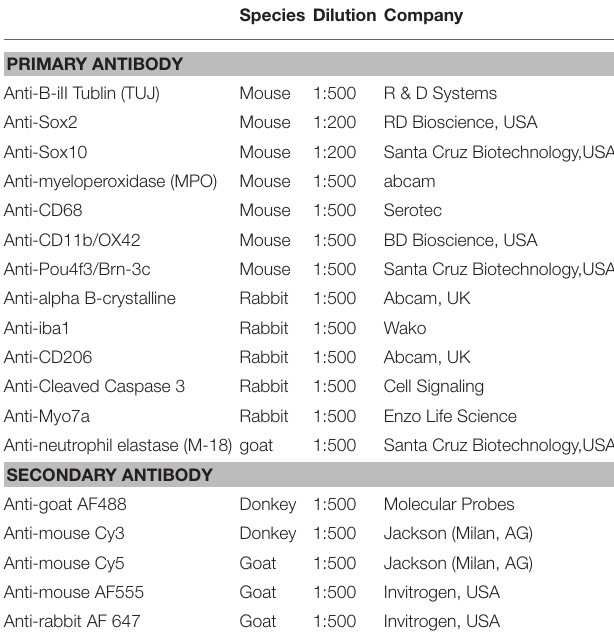
TABLE 1 | Antibodies used in the